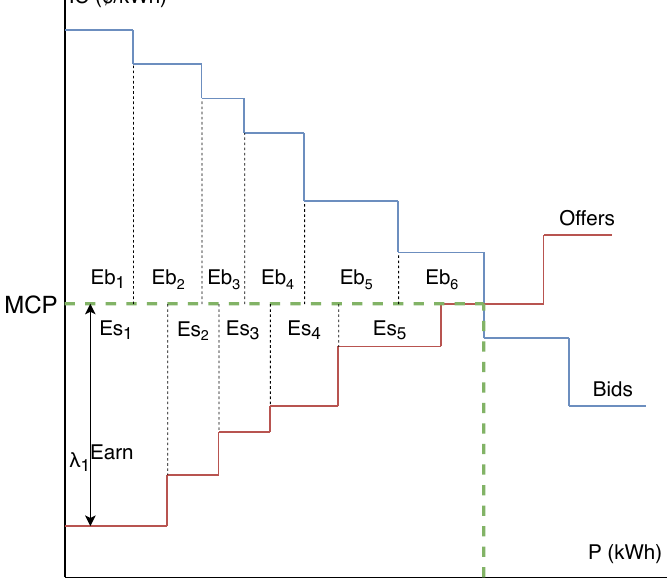
Figure 3. Market Clearing Price in Double Auction with earning component for each participant